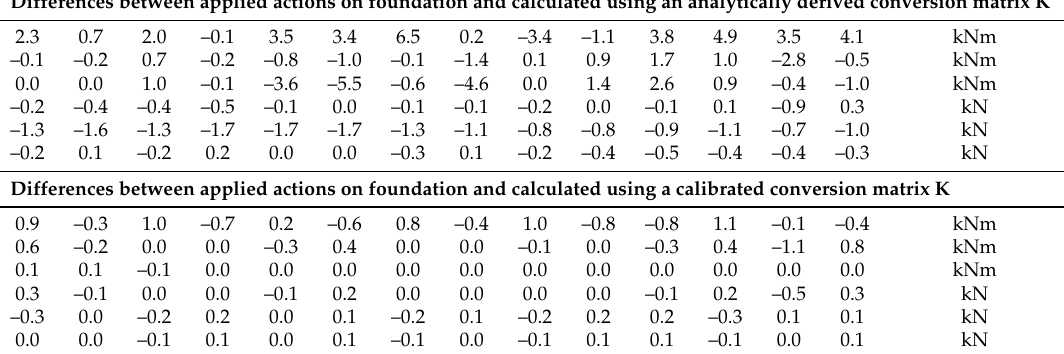
Table 3. Deviation of calculated actions on foundation [ M F ] T = K · R raw based on fourteen load cases determined according to Sections 5.3 and